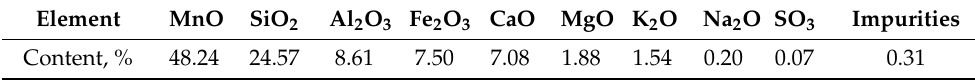
Table 1. Elemental composition of ferromanganese ore.